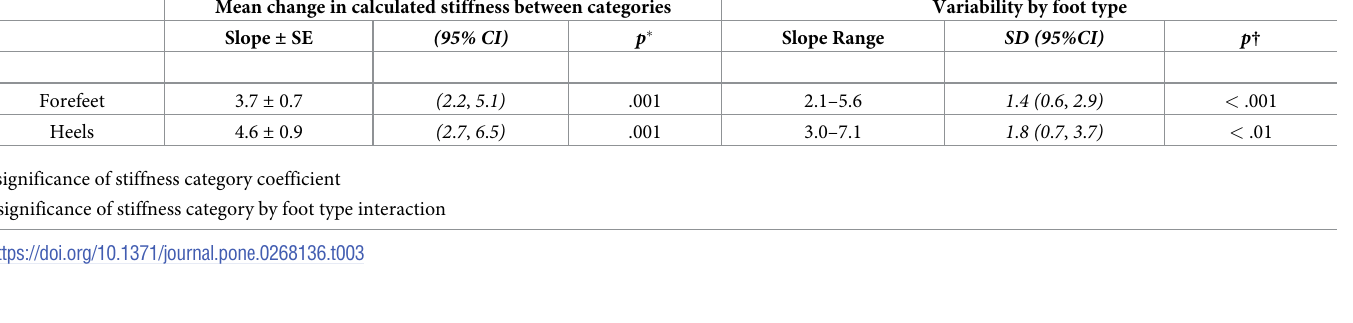
(SE), 95% confidence intervals (CI) and marginal R -squares ( R 2 ). Analyses were carried out